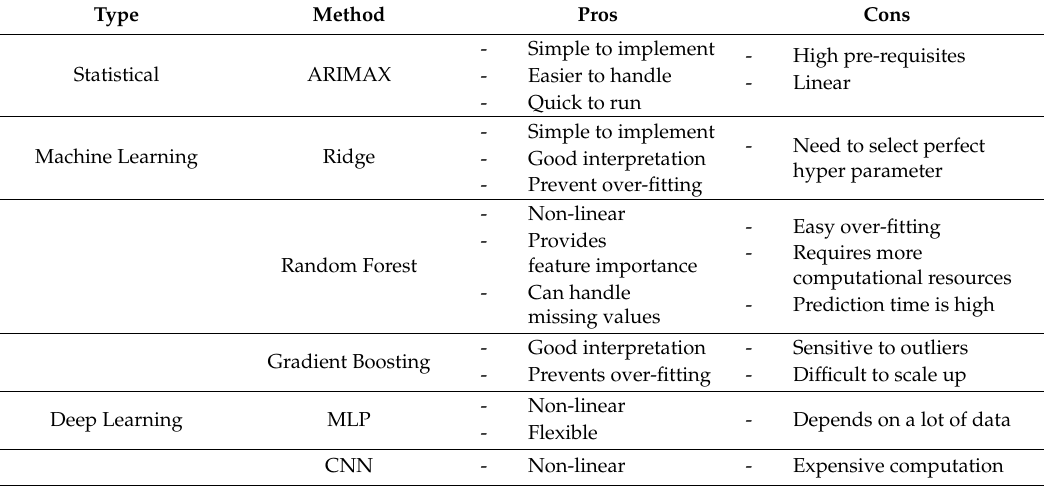
Table 6. Comparison of competing methods modified from